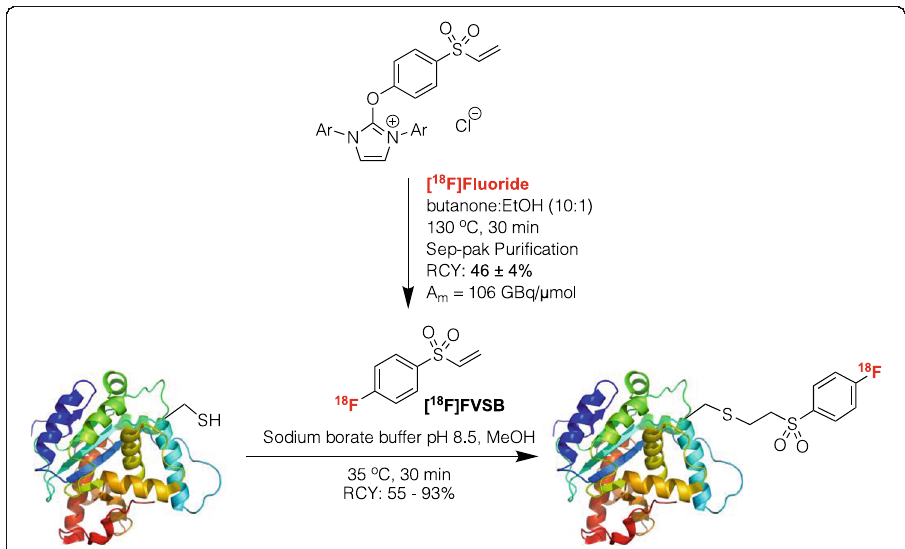
Fig. 6 [ 18 F]FVSB, a thiol reactive synthon for mild and rapid radiolabeling of peptides. Reprinted (adapted) with permission from Ma G, McDaniel JW, Murphy JM. One-step synthesis of [ 18 F]Fluoro-4- (vinylsulfonyl)benzene: a thiol reactive synthon for selective radiofluorination of peptides. Org